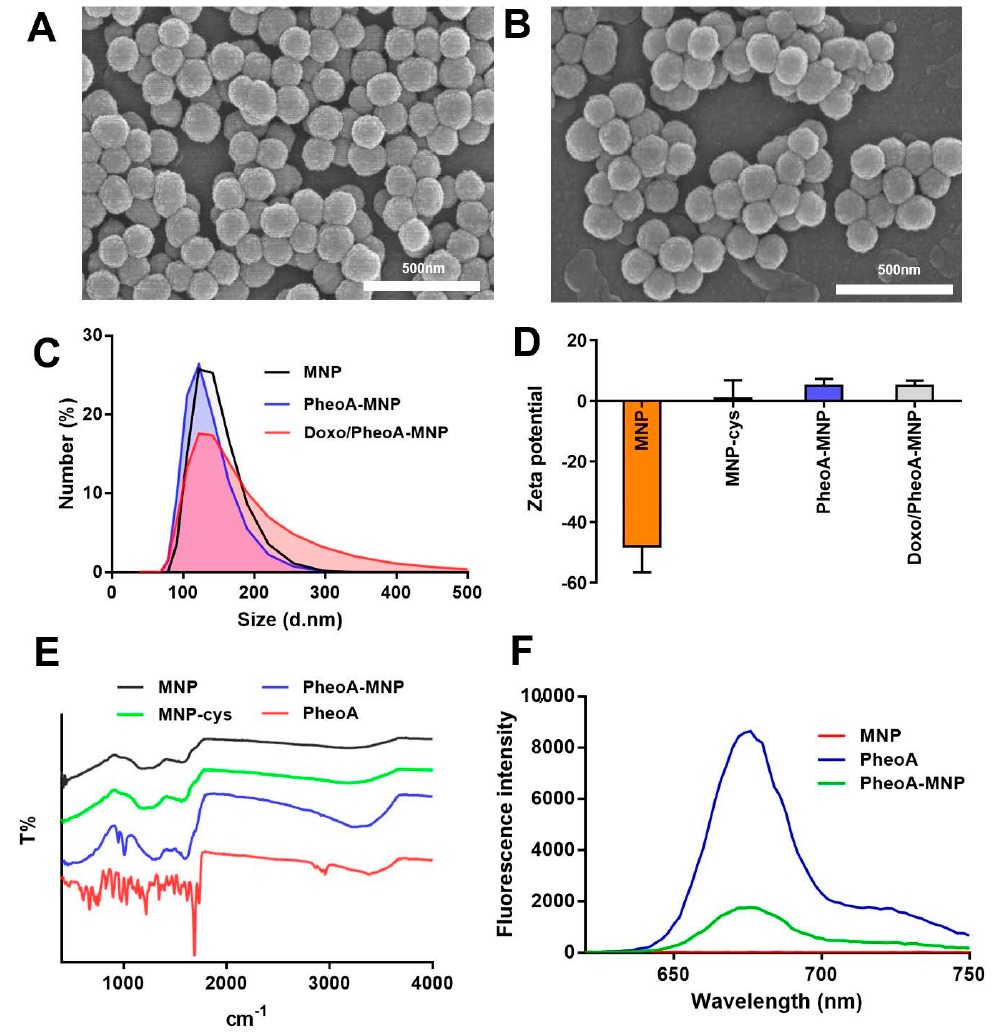
Figure 1. Scanning electron microscopy (SEM) images of ( A ) MNPs and ( B ) PheoA-MNPs (scale bar = 500 nm). ( C ) Size distribution of MNP (black), PheoA-MNP (blue) and Doxo/PheoA-MNP (red) determined by dynamic light scattering (DLS). ( D ) Zeta potential of nanoparticles. ( E ) FT-IR spectra of MNP (black), MNP-cystamine (green), PheoA-MNP (blue) and free PheoA (red). ( F ) The